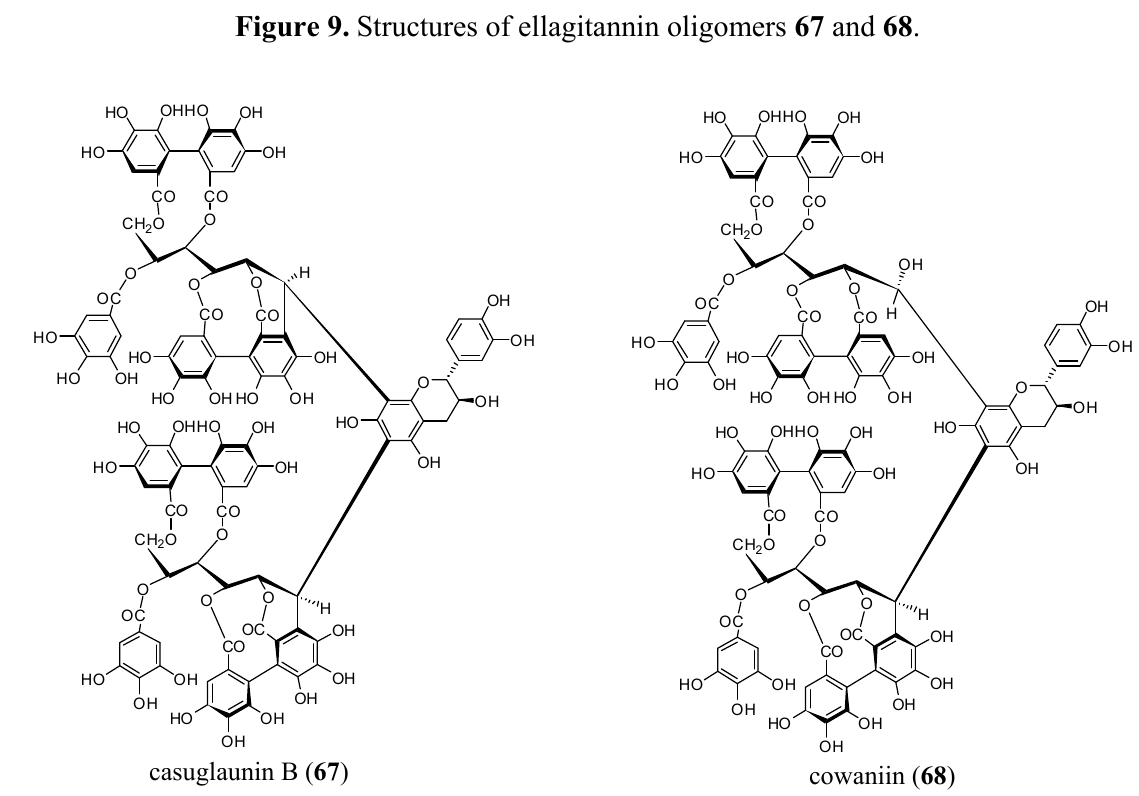
Figure 9. Structures of ellagitannin oligomers 67 and 68